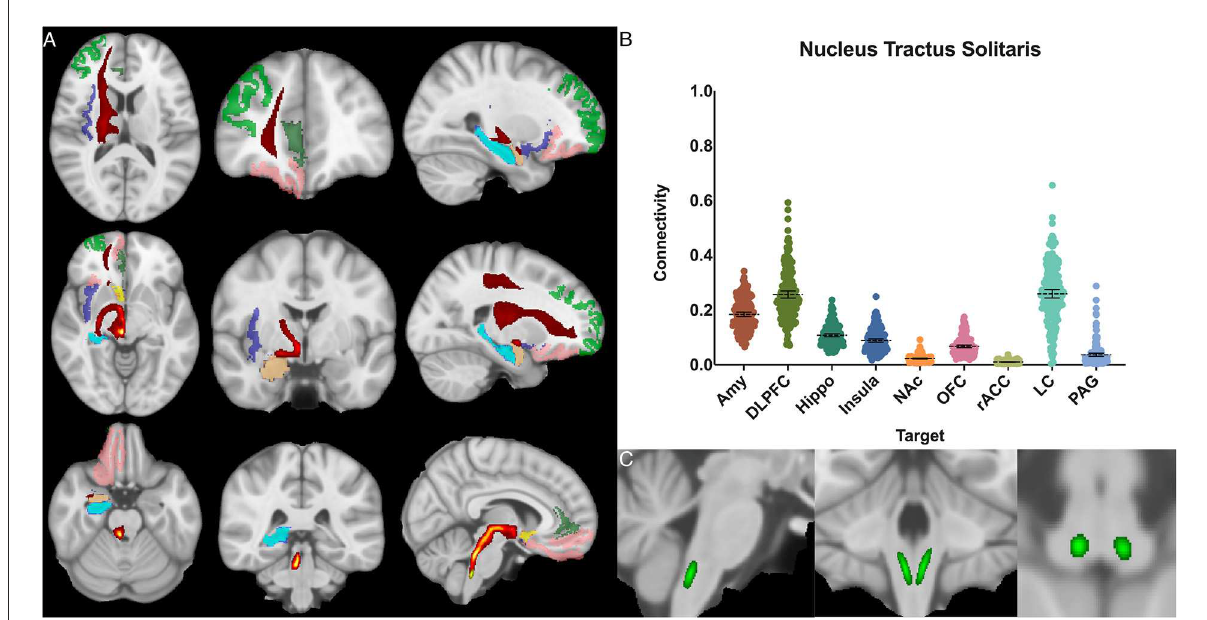
FIGURE5 Nucleus tractus solitarius structural results. (A) MNI space structural connectivity results visual representation averaged over all 197 subjects. Brighter yellow on heat map indicates a high number of samples passing through a given point that will eventually reach a target map (brighter yellow = more samples). Dark green: DLPFC; pink: OFC; brown: AMY; blue: HIPPO; purple: insula; orange: NAc; light green: rACC. (B) Mean connectivity results with dashed line showing mean and 95% CI, each point on graph shows result from individual subject. (C) Anatomic MNI mask of seed region.